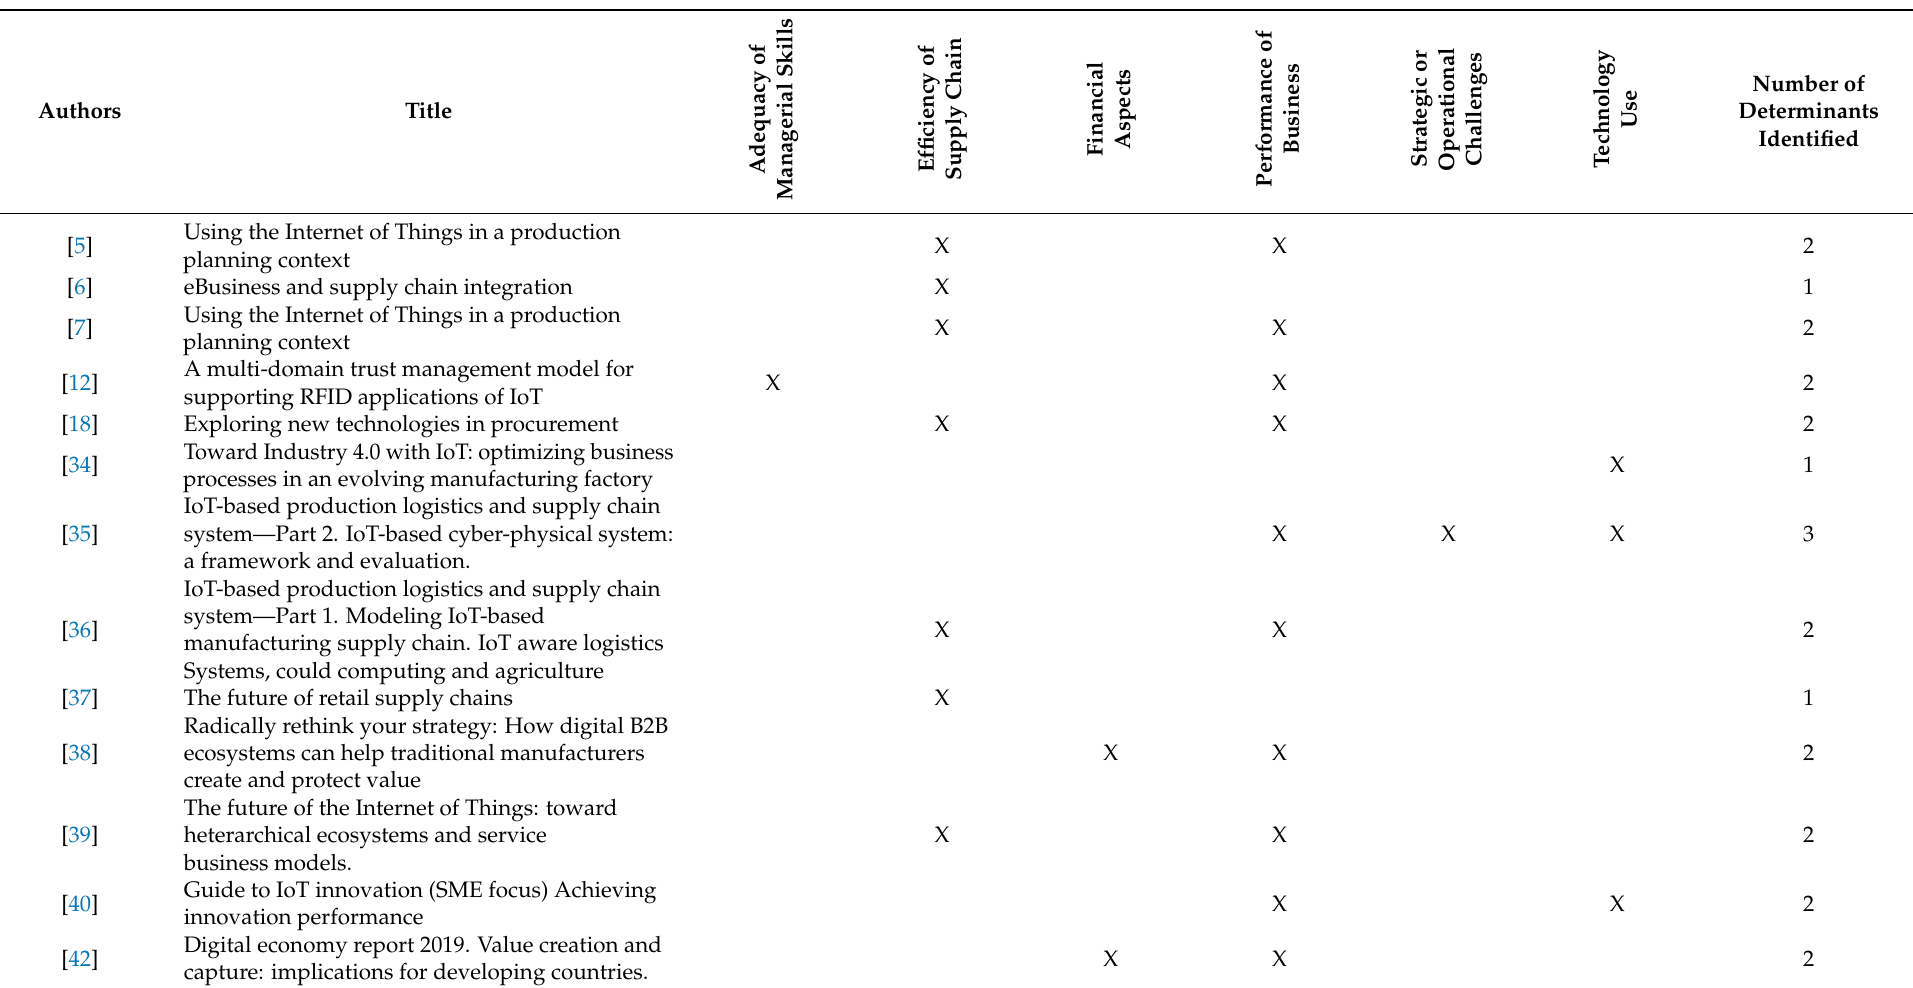
Table A1. Analysis of Literature on Smart Systems and the identification of the six key